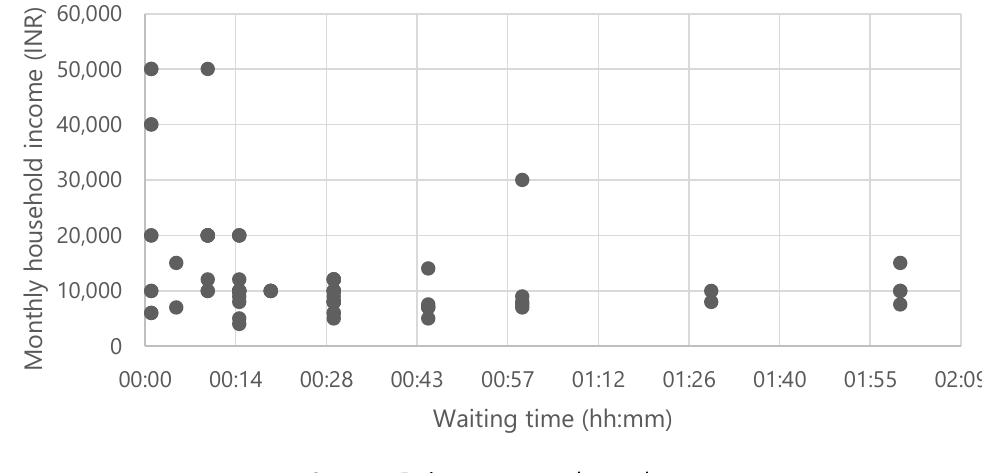
Figure 16: Monthly household income and waiting